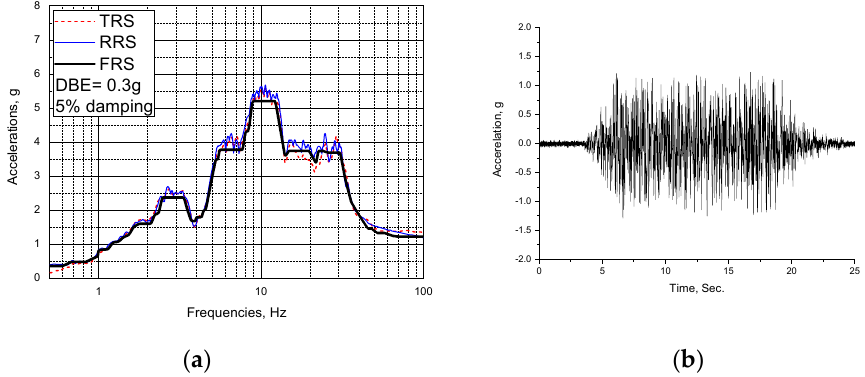
Figure 2. Input seismic data (SSE 0.3 g, 5% damping, 137 ft): ( a ) FRS; ( b ) time history.